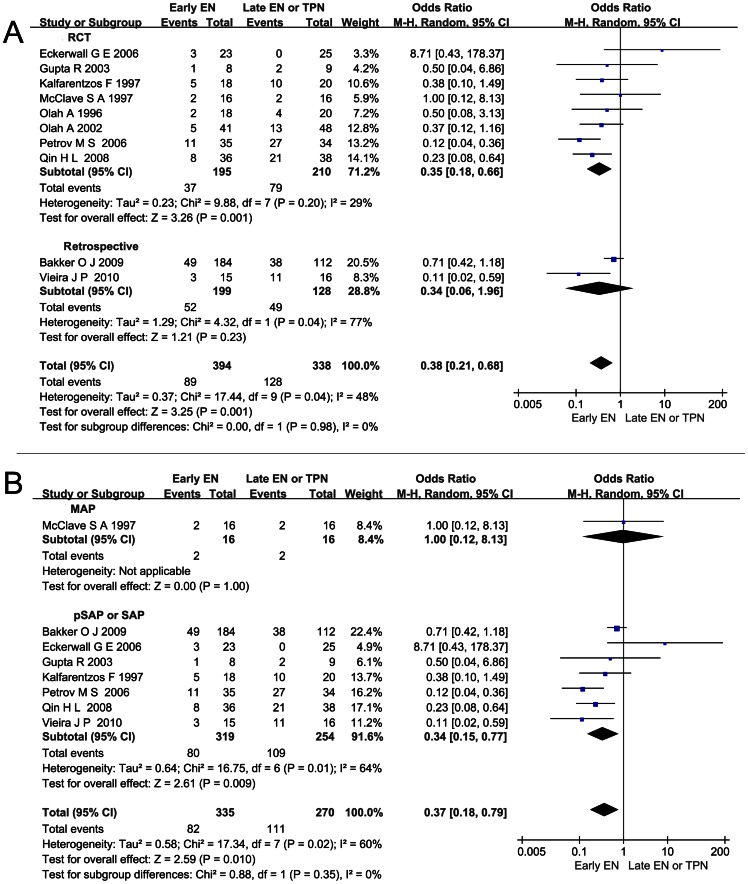
Effect of early EN on all the infection complications of AP as a whole.(A) Forest plot (Random-effect model) showing the effect of early EN on all the infection complications of AP as a whole and the sensitivity analysis subtotaling the plots by RCTs vs. retrospective studies. (B) Forest plot (Random-effect model) of the stratified study conducted based on the severity of AP.